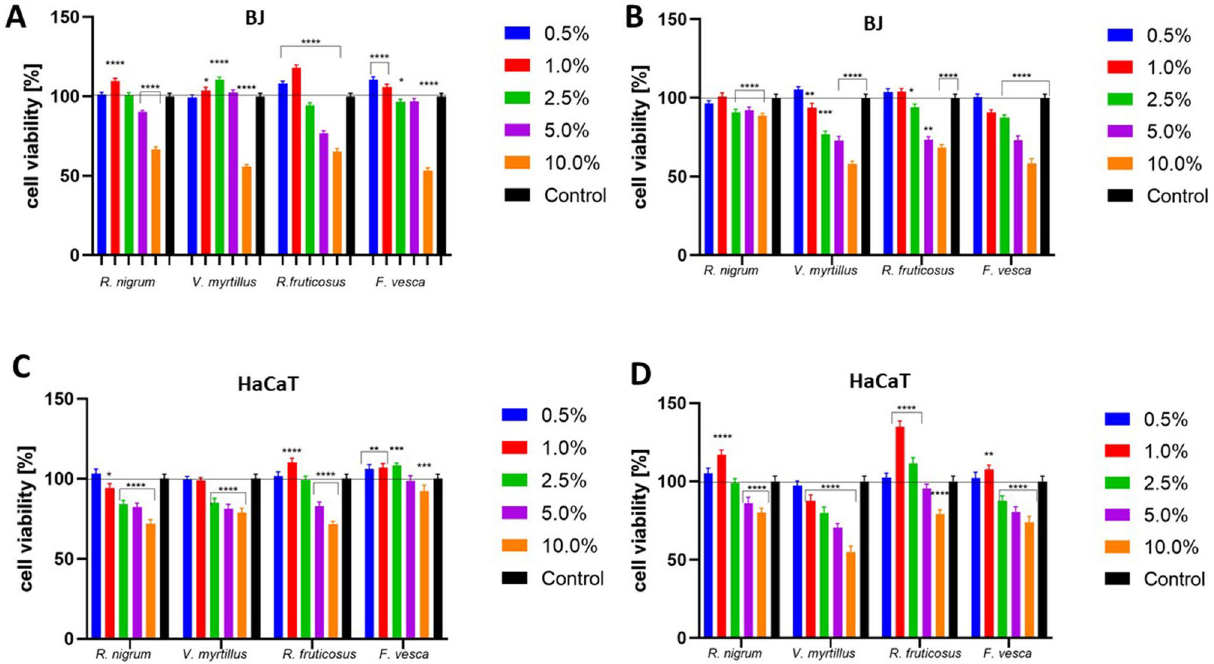
Figure 2. Cytotoxicity assessment of water-glycerin extracts from leaves of Ribes nigrum L., Vaccinium myrtillus L, Rubus fruticosus L. and Fragaria vesca L . on fibroblasts (BJ) ( A , B ) and keratinocytes (HaCaT) cells ( C , D ) after 24-h exposure assessed by the Alamar Blue assay ( A , C ) and Neutral Red assay ( B , D ). Data are the mean ± SD of three independent experiments in which each concentration tested was performed in four replications. The control was cells not treated with extracts, whose viability was assumed to be 100%. ****p < 0.0001, ***p < 0.001, **p < 0.01, *p < 0.03 versus the control